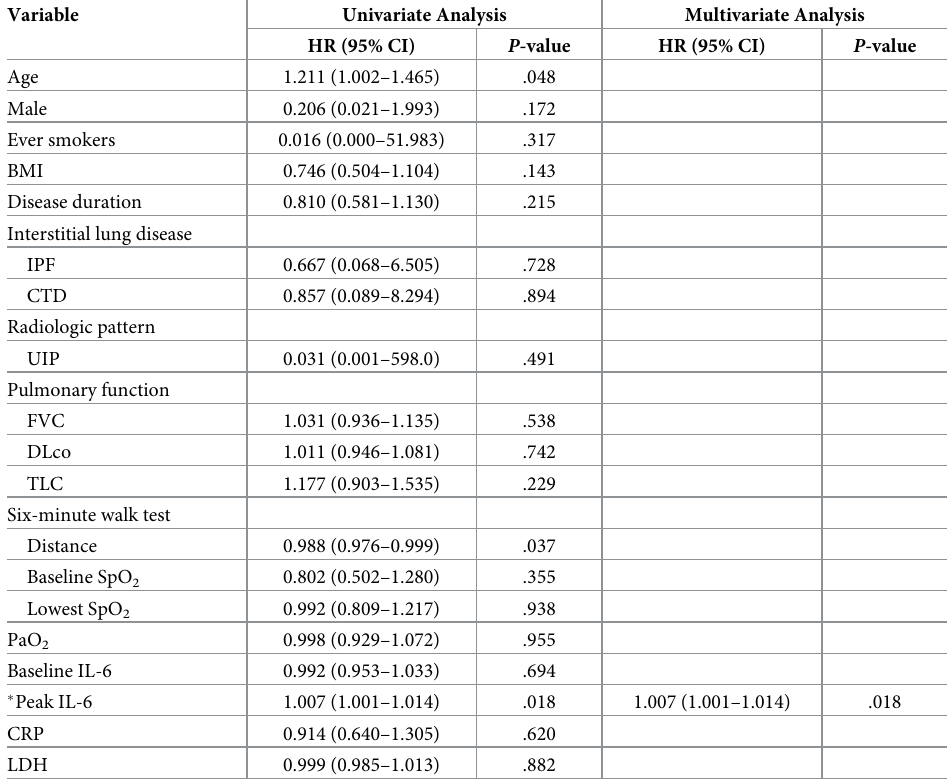
Table 4. Prognostic factors for mortality in patients with ILD assessed using cox proportional hazards model.